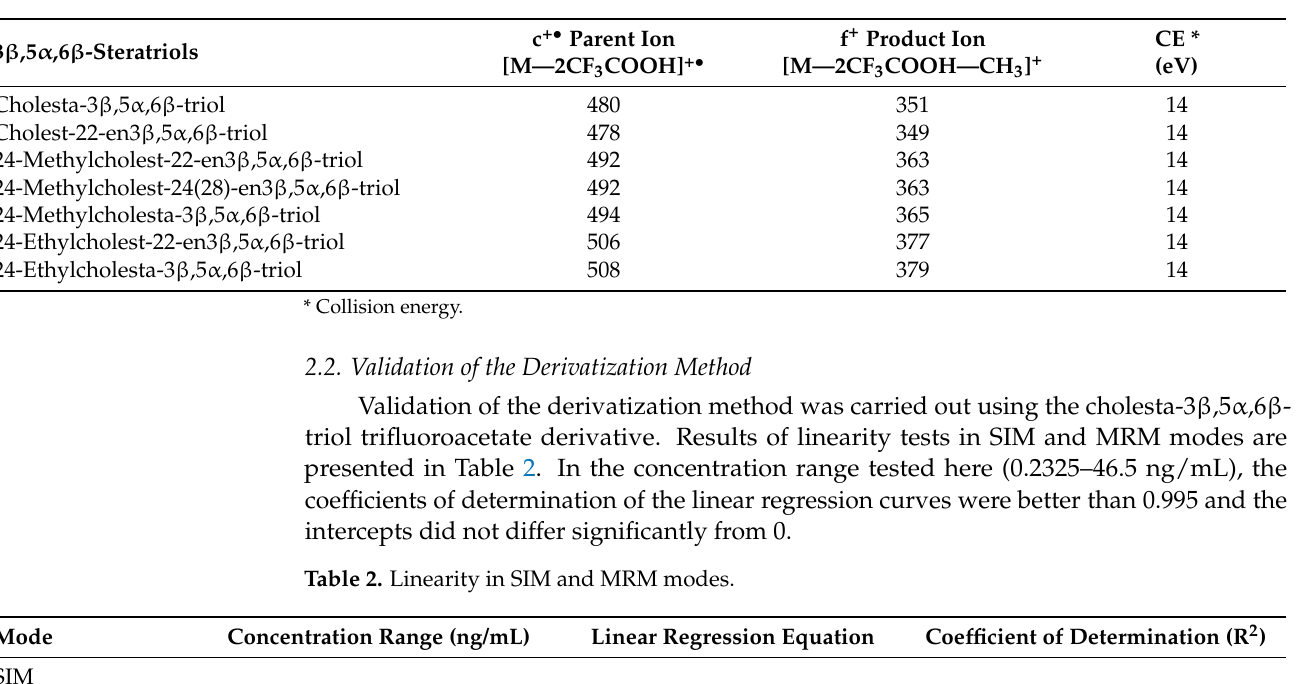
Figure 4. CID mass spectrum of the c + • ion at m/z 480 (collision energy: 14 eV) (+ • = radical cation, + = cation, ⧫ = parent ion). Table 1. MRM transitions employed for the quantification of 3 β ,5 α ,6 β -steratriols originating from